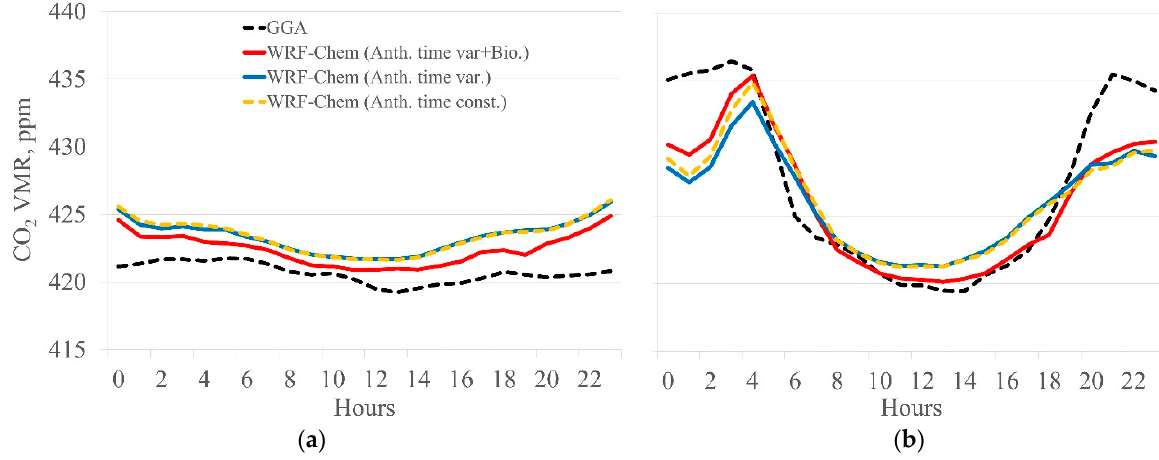
Figure 11. Monthly-averaged diurnal variation of near-surface CO 2 mixing ratio according to the WRF-Chem runs and in situ observations in Peterhof in March ( a ) and April ( b ) 2019.